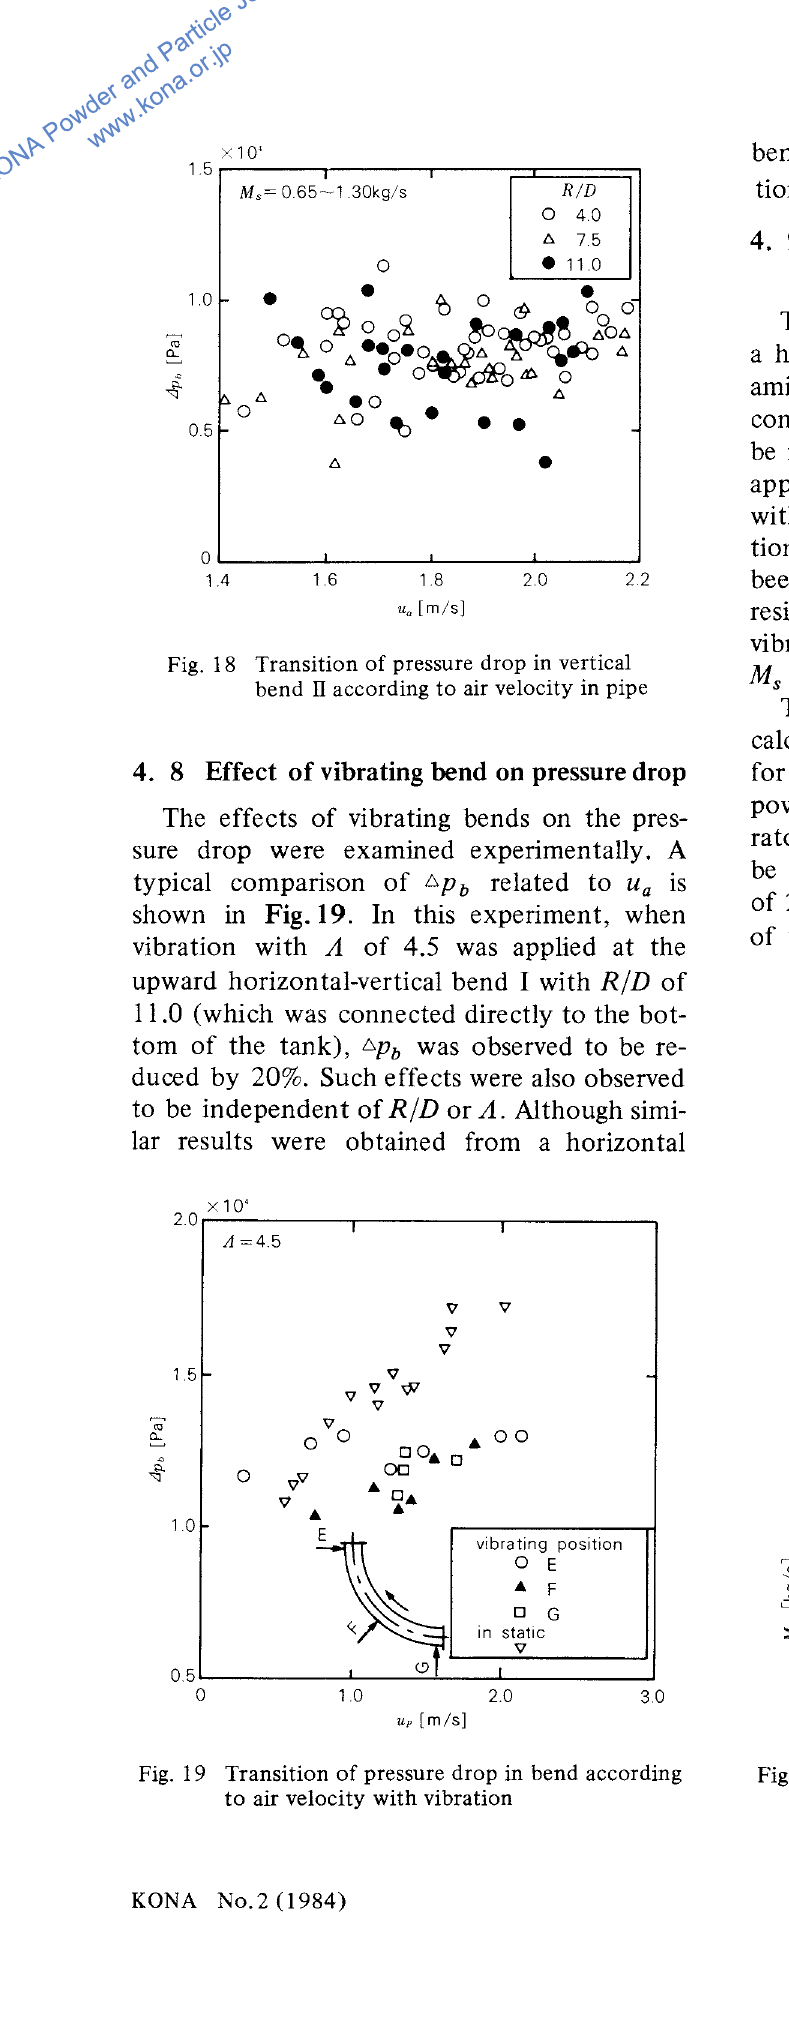
Fig. 19 Transition of pressure drop in bend according to air velocity with vibration